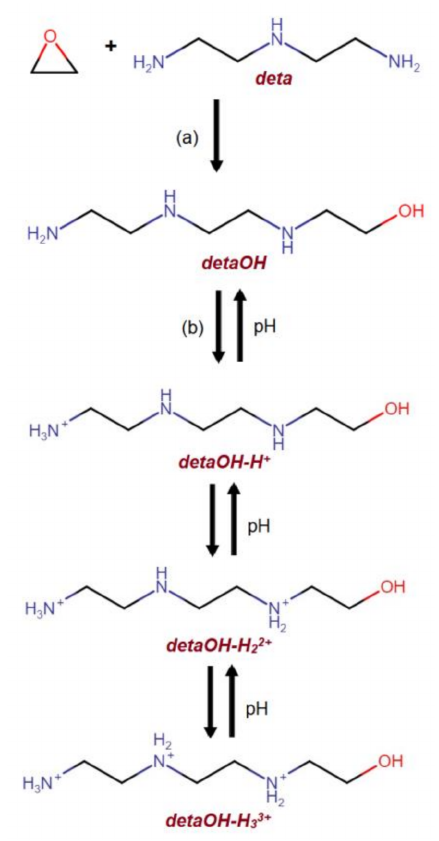
Figure 10. The reaction of functionalization of starting epoxy copolymer by deta amine ( a ) and the equilibrium of detaOH absorption centers ( b ) used in model systems for estimation of the binding energies of vanadium (V) oxyanion to the